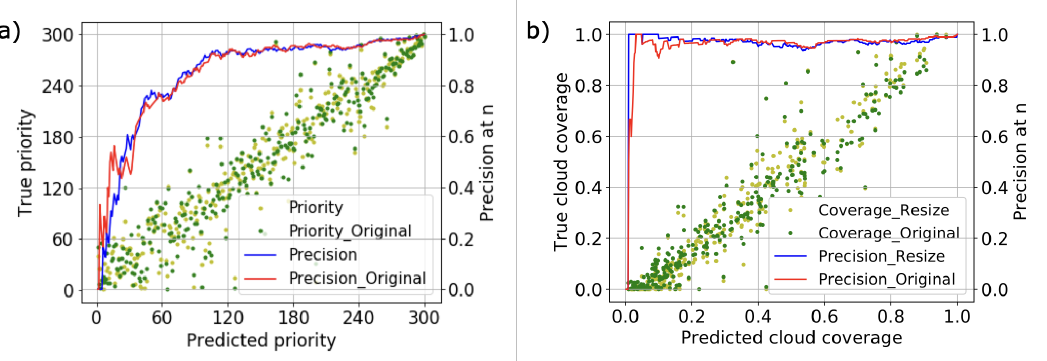
Figure 9. ( a ) Priority and ( b ) cloud coverage prediction results compared against labels before and after resize. The results show a similar trend between before and after resize, which indicates the resize method can be considered valid.